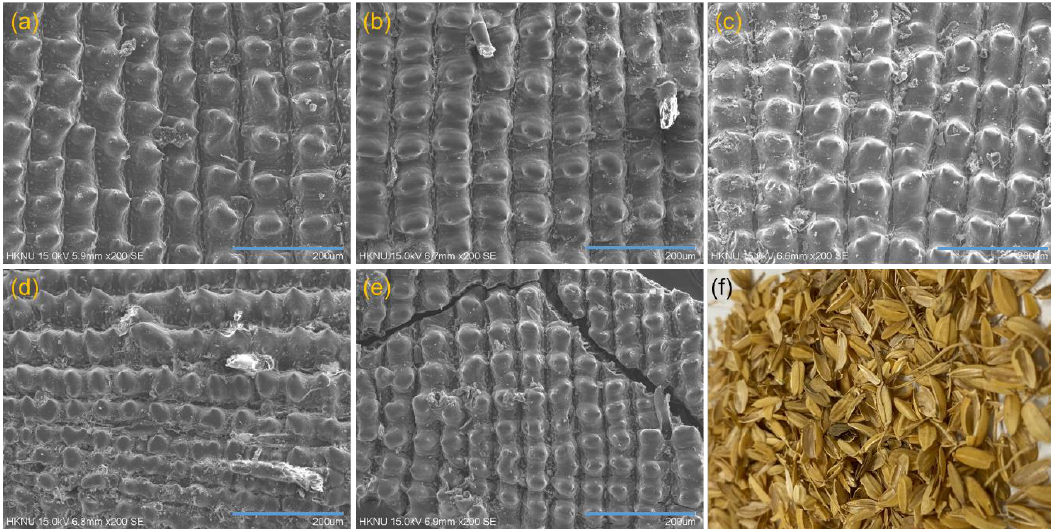
Figure 2. Field emission-scanning electron microscope photos of rice husk thermally treated. ( a )